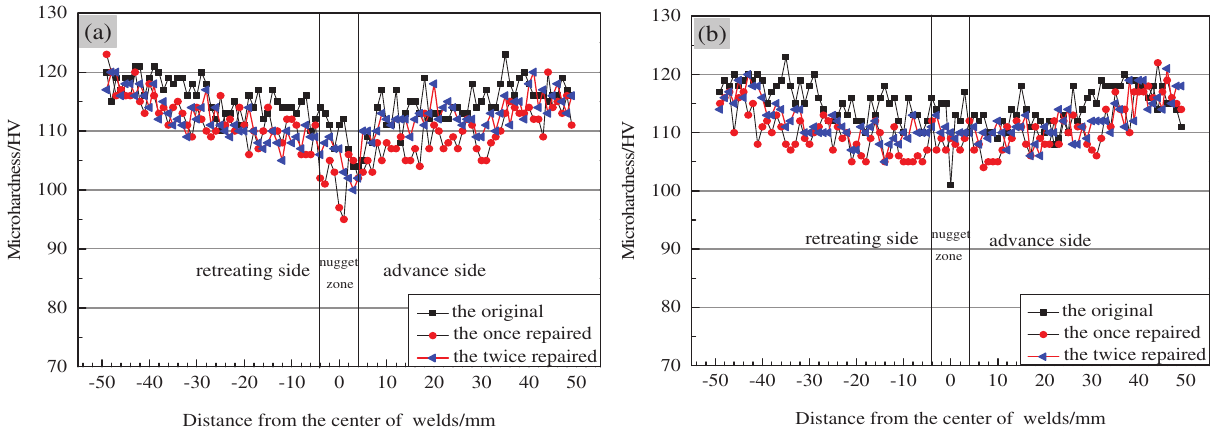
Figure 4: Hardness profiles of original and repaired joints: (a) distanced 2 mm from the top surface; (b) distance 2 mm from the bottom surface.